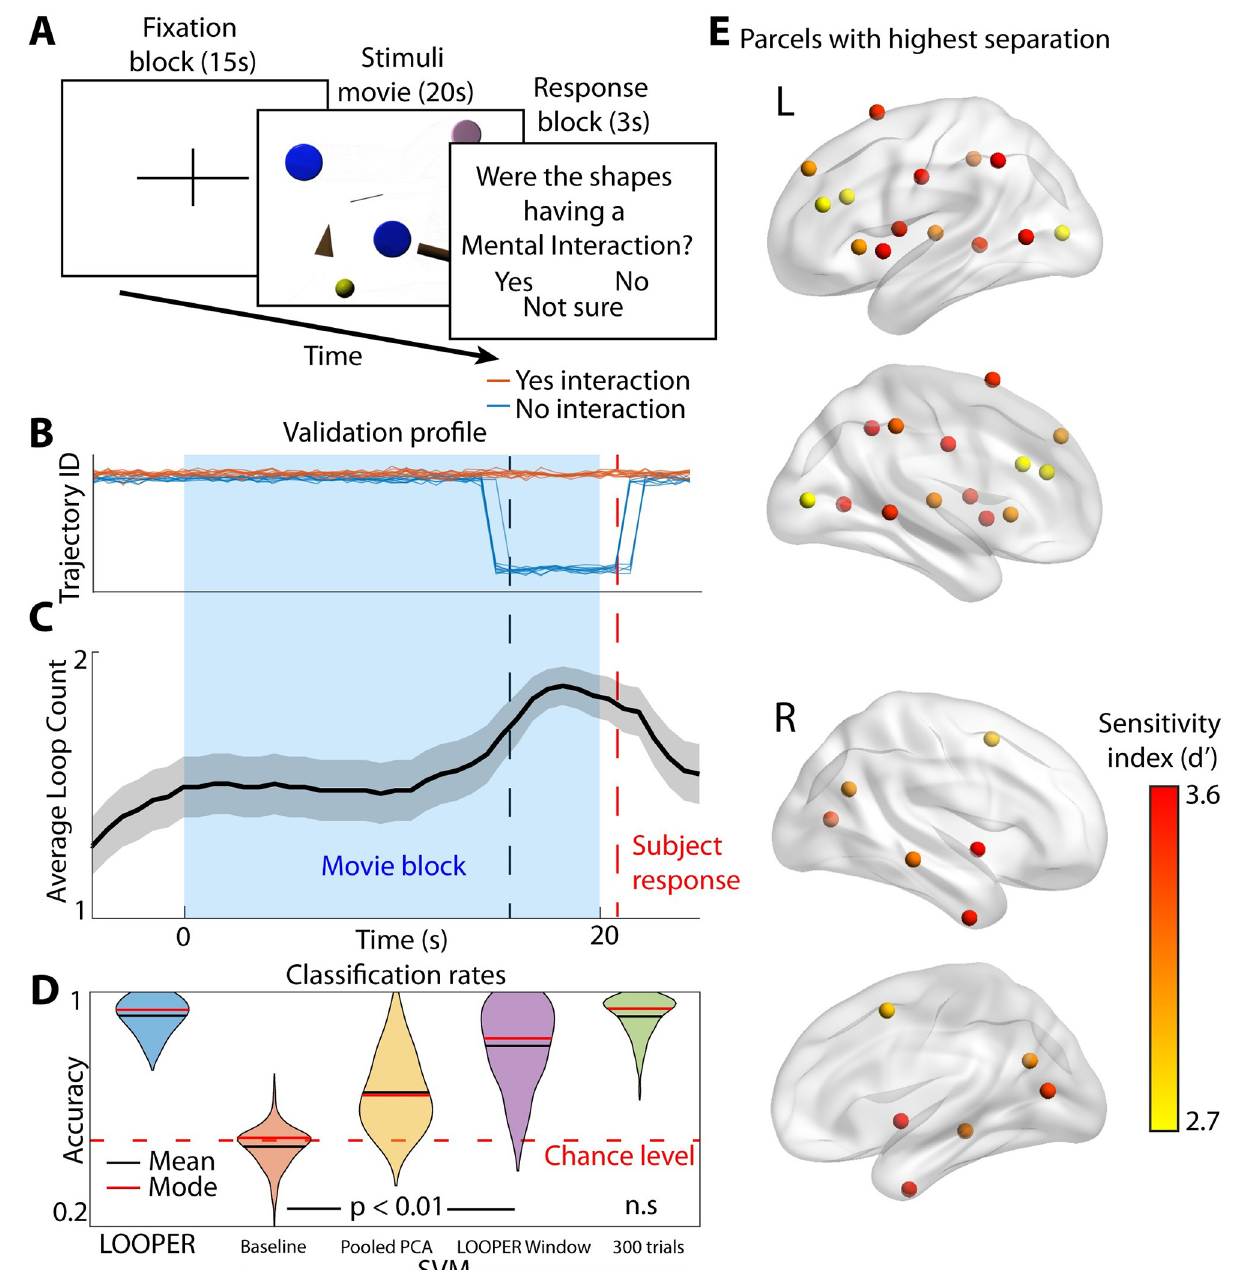
Fig 4. Computational scaffold of neuronal dynamics extracted using LOOPER predicts choices on the theory of mind task. A ) Schematic of the “human theory of mind” task. Subjects are shown videos of shapes moving on the screen and are asked whether the shapes are having a mental interaction or not. We build the LOOPER model on only those trials in which the subjects answered either “Yes” or “No”. B) Validation trials excluded from model construction are projected onto their closest model bin at each time step. A stereotypical example of the computational scaffold. Each trial in the validation set is colored by whether the subject responded that “Yes, they do think there was an interaction” (orange traces), or “No, they don’t think there was an interaction” (blue traces). Notice that the two conditions diverge near the end of the movie and during the response window. This is consistent with accumulation of information throughout the movie that eventually culminates in a binary decision (validation accuracy 98.8%, n = 1000). C) Due to the high amount of noise in the fMRI signal the exact timings of divergence of trajectories is parameter dependent. To ensure that our result is robust with respect to parameter choices, we explore the effect of parameter values on the computational scaffold. The average number of trajectories and the 95% confidence interval is plotted at each time point. D) Accuracy of decoding the response using LOOPER and standard supervised techniques used in fMRI literature (SVM). All reported accuracies are on the validation dataset. The baseline SVM classifier used the same training data as LOOPER (10 trials of each condition bootstrapped over 60 subjects). For LOOPER, the raw parcel time series were used. For SVM, the